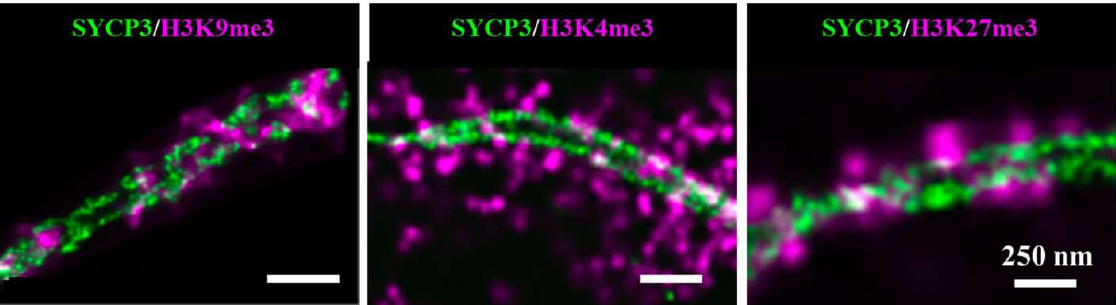
Figure 7. Visualizing spatial epigenomics using localization-based super-resolution microscopy. Two-color super-resolution images of chromosomes (green) and histone marks (magenta) via im- munostained with anti-SYCP3 (Alexa 555) and anti-histone modifications (Alexa 488). Adapted with permission from [94] , 2022, John Wiley and Sons.